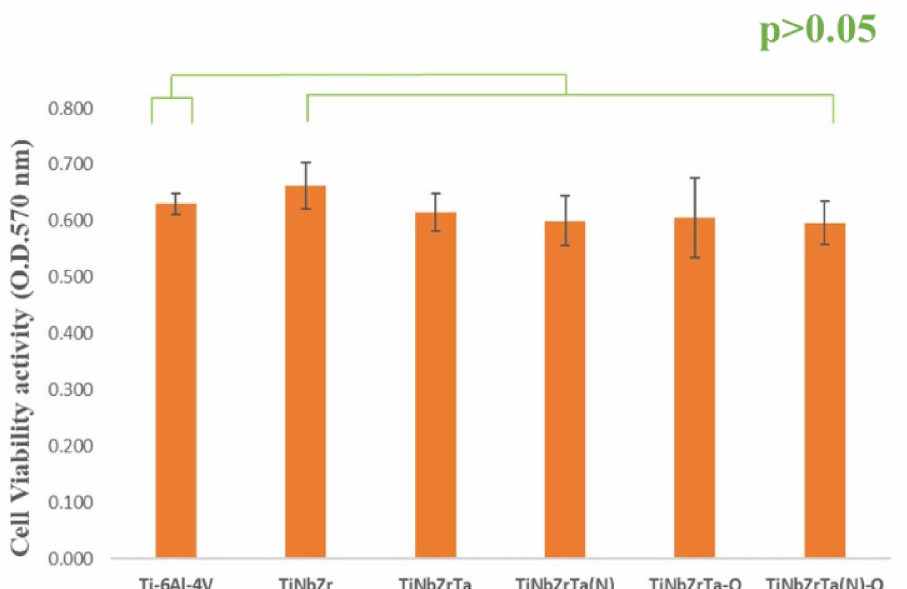
Figure 7. Cell viability analysis of MG-63 cells cultured on uncoated Ti-6Al-4V and TiNbZrTa series films for 48 h. No significance was noted among these groups ( p > 0.05).